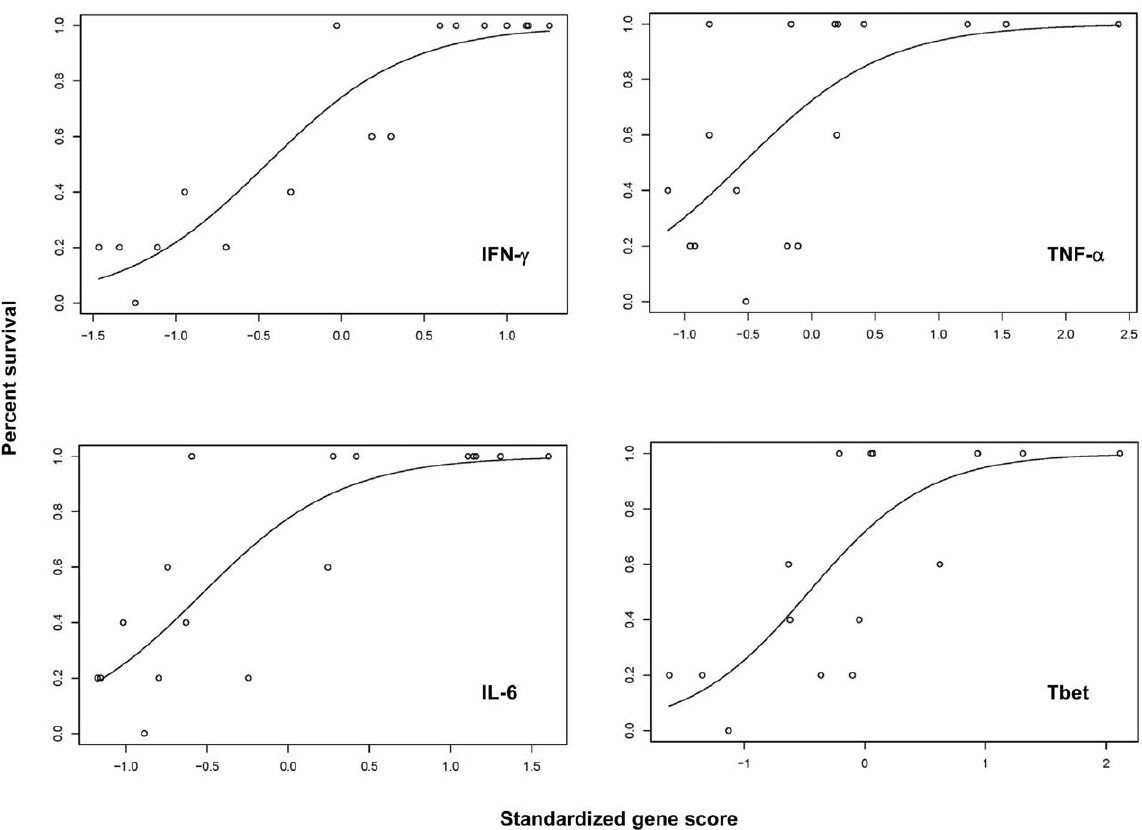
Figure 5. Relationship between gene expression and survival across all vaccines studied at six weeks after vaccination for IFN- c , TNF- a , IL-6, and T-bet. Data from Table S2, all experiments, were analyzed by logistic regression across all vaccines and all time points as described in the text. For each individual gene, the plotted results shown depict the percent survival of LVS-challenged mice as a function of the standardized score of the log 10 fold difference in gene expression. All mediators depicted here exhibited a significant positive relationship between the degree of gene expression and survival (see Table 1 and Table S4).